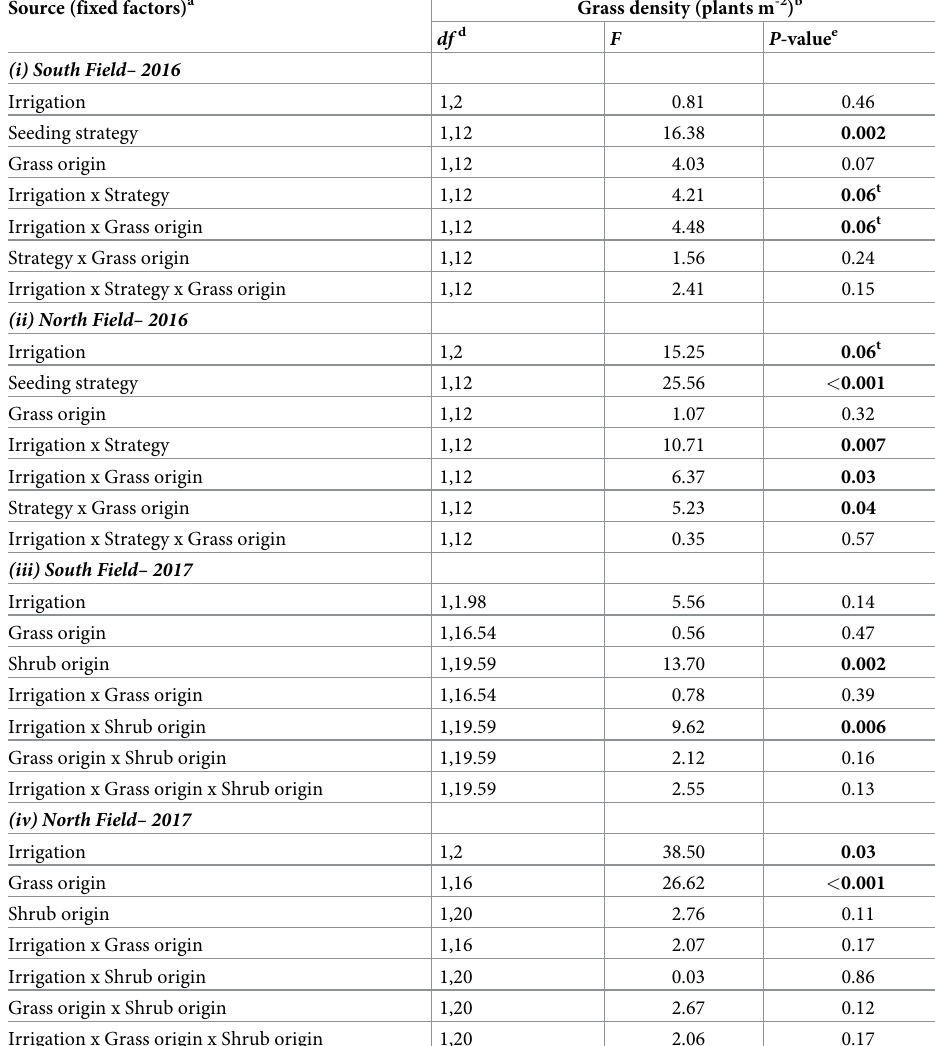
Table 3. Model results for grass density in 2016 and 2017 at both